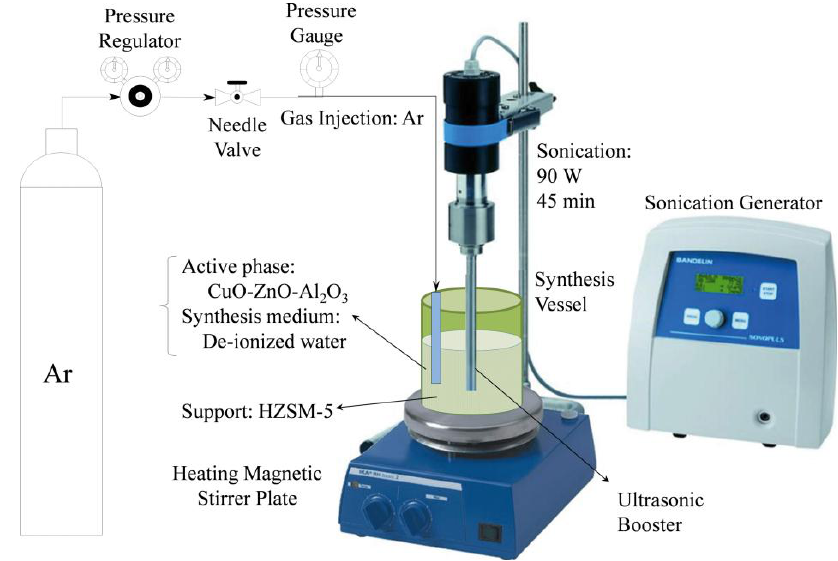
Figure 13. Experimental setup for dispersion of CZA over HZSM-5 using US energy. Reprinted from Ref. [90]. Copyright 2014 with permission of The Royal Society of Chemistry.